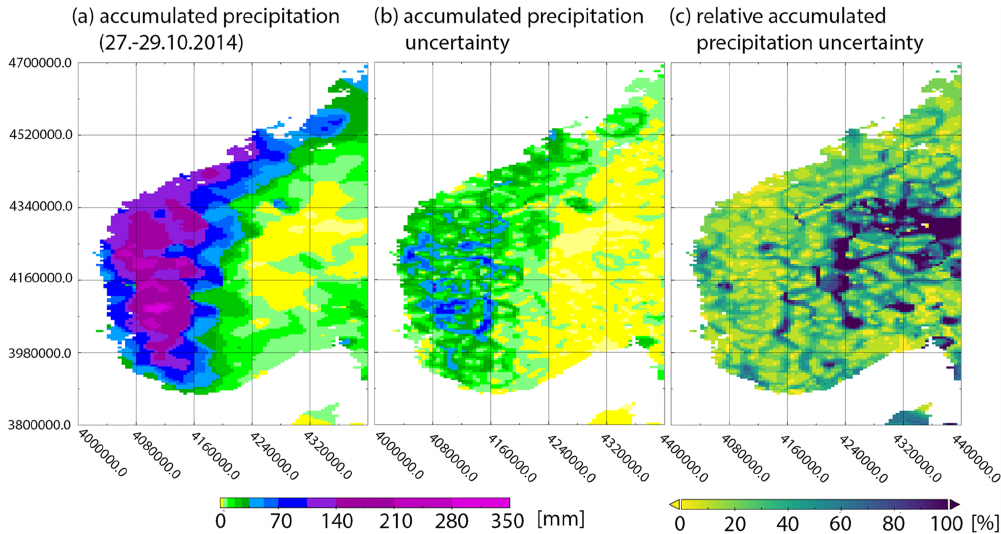
Figure 8. Example of interpolated precipitation totals and associated uncertainty for extreme event no. 3 in Sect. 4.3. (a) Accumulated precipitation totals from 27–29 October 2014 (3d), (b) accumulated uncertainty of the interpolated precipitation totals, and (c) the percentage of the accumulated uncertainty in relation to the accumulated precipitation